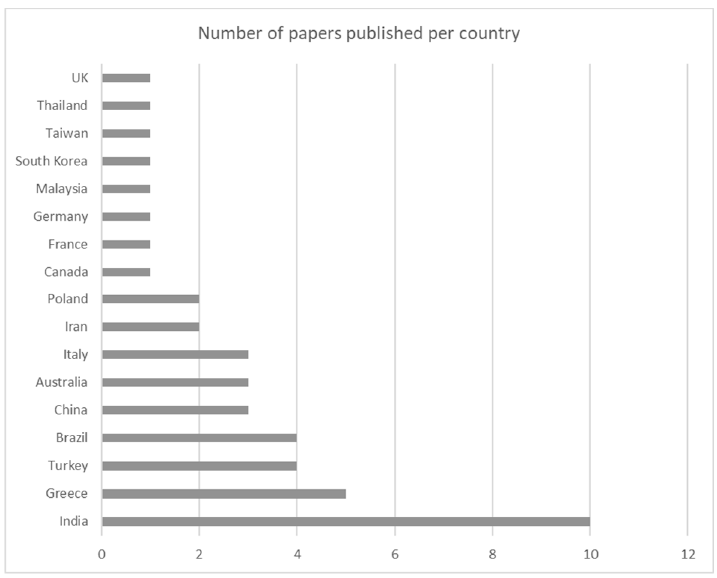
Figure 6. Number of papers published per country.